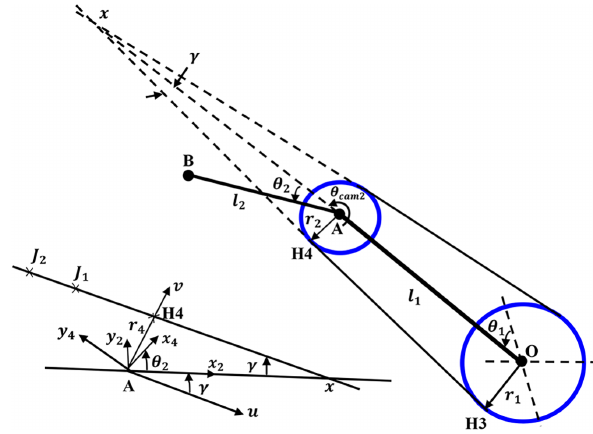
Figure 5. Geometrical analysis of cam 2